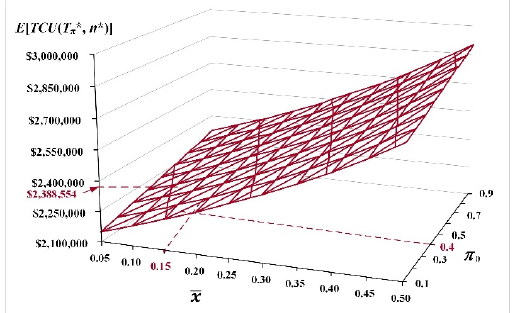
Fig. 10. E [ TCU ( T π *, n *)]’s behavior relating to the mean scrap rate and π 0